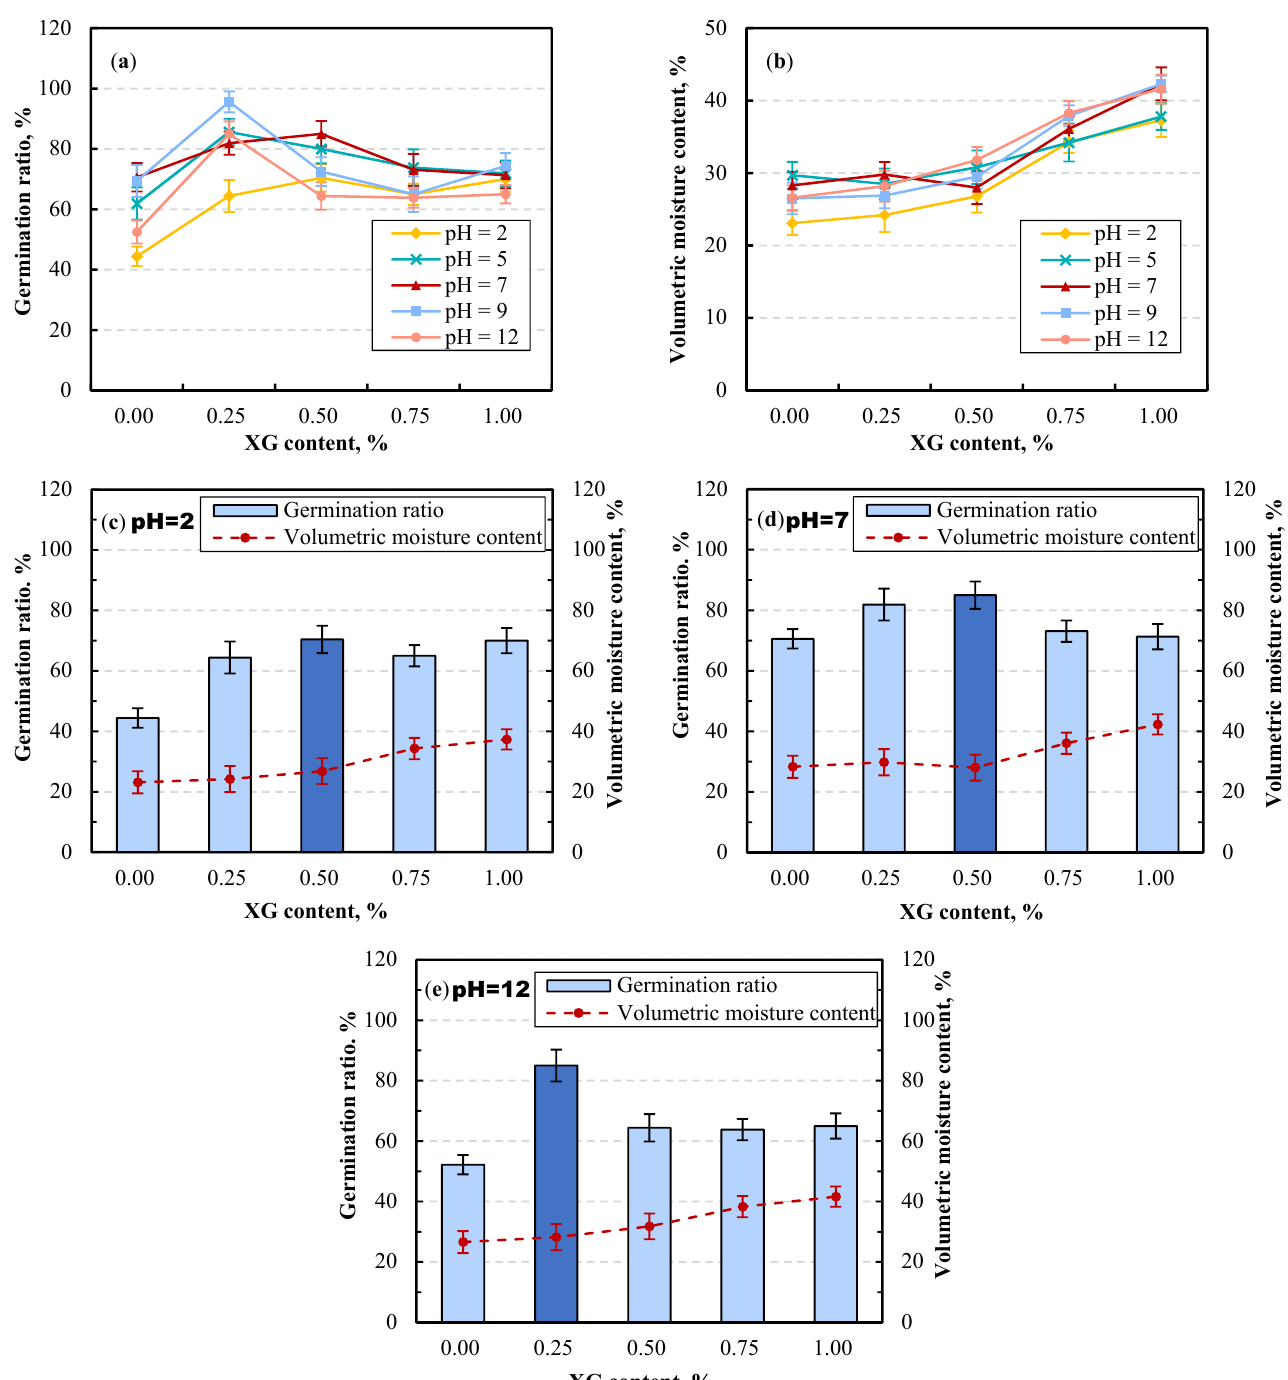
Figure 12. ( a ) Germination ratio versus XG content; ( b ) volumetric moisture content versus XG content; ( c ) germination ratio and volumetric moisture content versus XG content (pH = 2); ( d ) germi- nation ratio and volumetric moisture content versus XG content (pH = 7); ( e ) germination ratio and volumetric moisture content versus XG content (pH = 12).